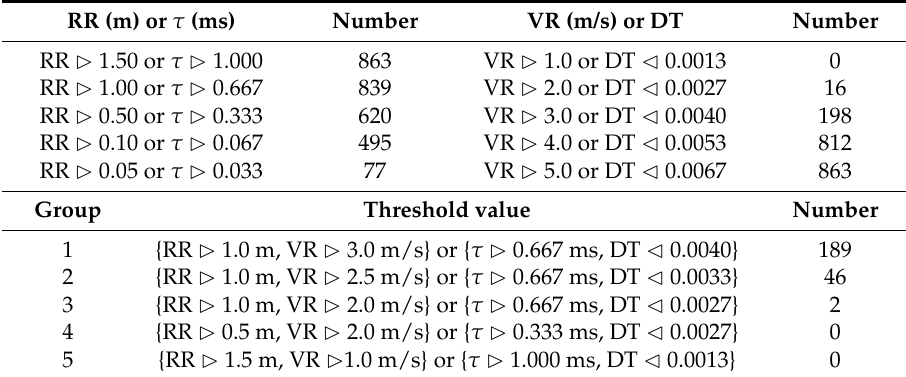
Table 1. The number of call pulses under different RR and VR (or DT) threshold values.